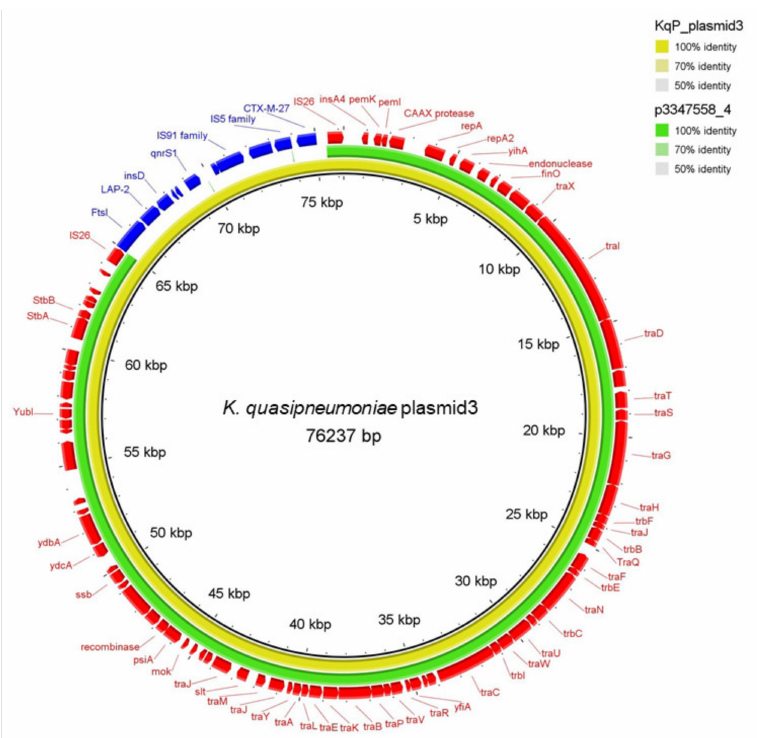
Figure 1. Comparison of the K. quasipneumoniae plasmid and the reference plasmid p3347558_4 using BRIG. The outer Ring shows the annotated sequences by dfast: The AMG cassette is colored in blue, all other proteins are colored in red.